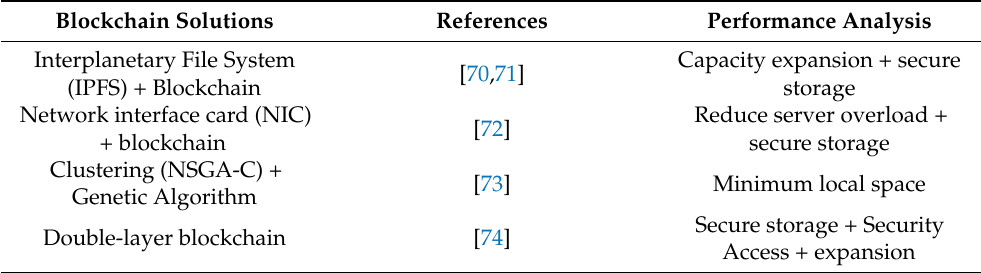
Table 2. Data storage blockchain